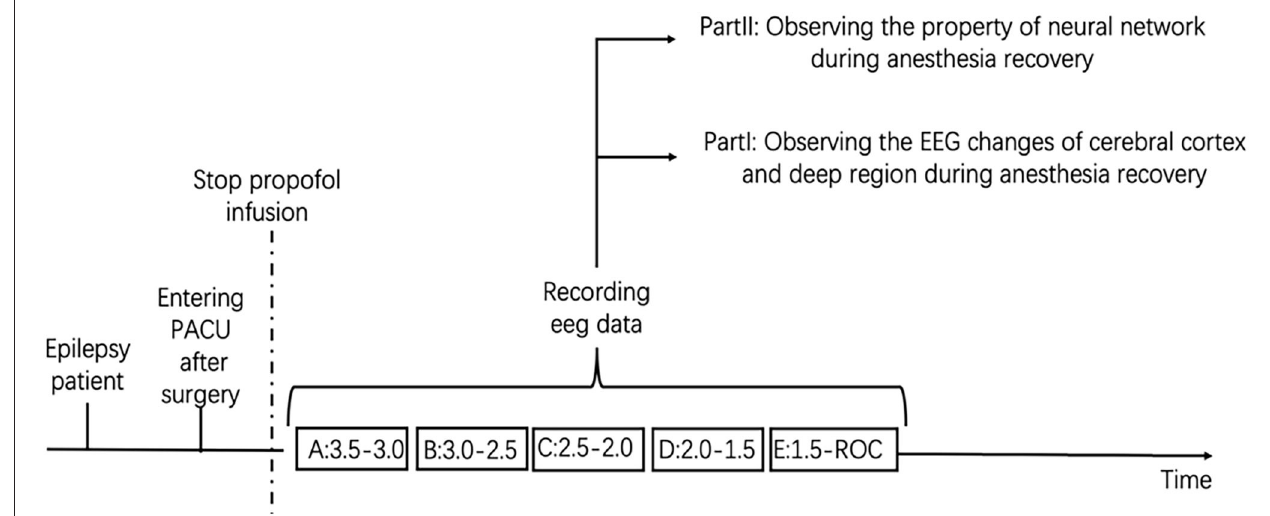
FIGURE 1 | Experimental flow